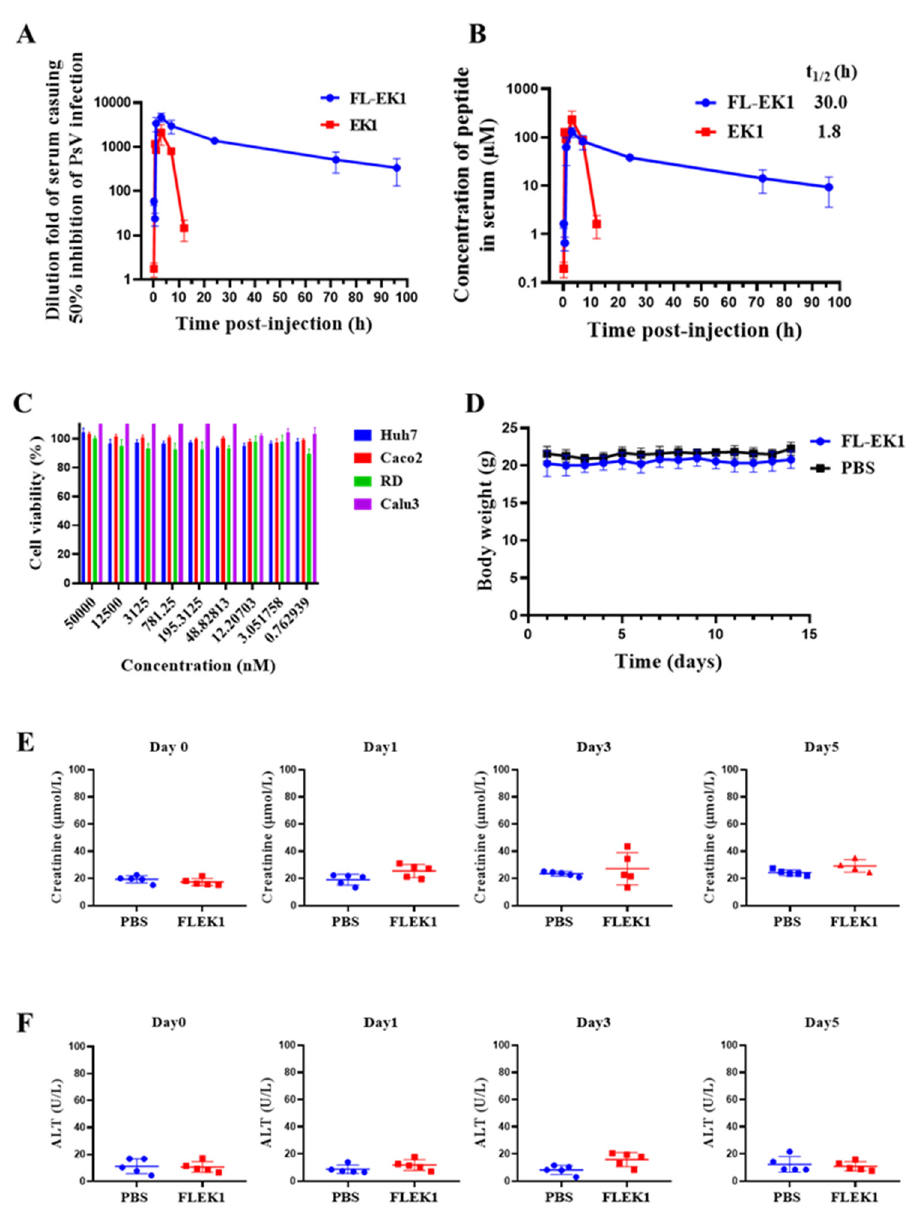
Figure 6. Ex vivo anti-SARS-CoV-2 PsV activity and concentrations of FL-EK1 and EK1 in mouse serum and evaluation of in vitro cytotoxicity and in vivo safety of FL-EK1. ( A ) Ex vivo anti-SARS- CoV-2 PsV activity of serum samples collected from mice at different time points after intraperitoneal injection of FL-EK1 and EK1 ( n = 3). ( B ) Concentration of FL-EK1 and EK1 in mouse serum samples and the half-life of each were estimated. ( C ) In vitro cytotoxicity of FL-EK1 at the graded concentration on Huh7, Caco2, RD, and Calu3 cells. ( D ) Bodyweight changes of mice treated with FL-EK1 via the intranasal route. ( E ) Creatinine in serum samples of mice treated with FL-EK1 via intranasal administration was measured by using a creatinine assay kit. ( F ) ALT in serum samples of mice treated with FL-EK1 via intranasal administration was measured by an ALT assay kit. Samples were tested in triplicate, and the experiment was repeated three times. Data from a representative experiment are presented as mean ± SD.